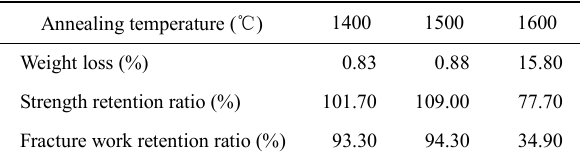
Table 3 Weight loss and mechanical properties of C/PyC/mullite composites after